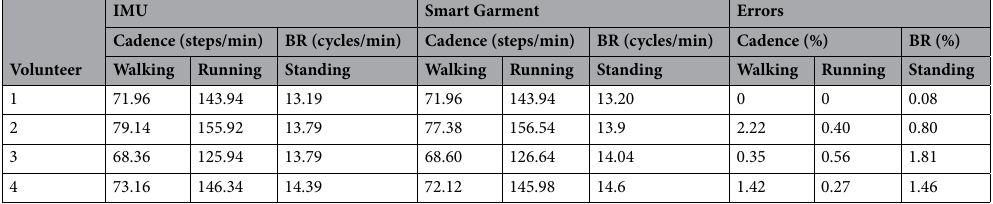
Table 3. Estimated parameters from IMU (reference) and Photonic Smart Garment sensors: errors between the measurements obtained from the two systems.